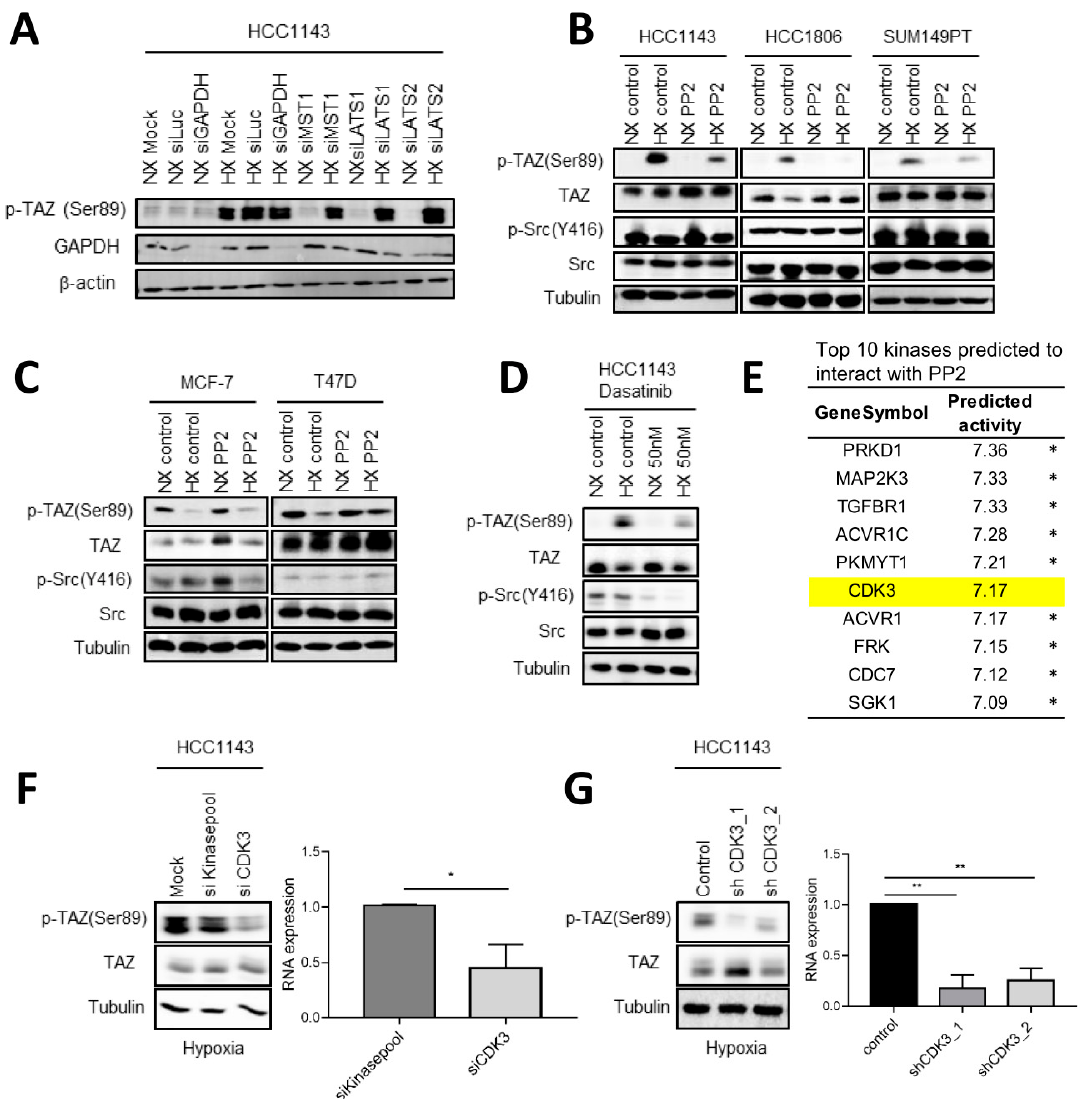
Figure 8. Src and CDK3 mediate phosphorylation of TAZ on Ser89 under hypoxia in basal A cells. ( A ) Western blot analysis of p-TAZ (Ser89) in HCC1143 cells treated with the indicated SMARTpool siRNAs targeting components of the Hippo signaling cascade or luciferase or GAPDH as controls and exposed for 5 days to normoxia (NX) or hypoxia (HX) from two biological replicates. β -actin serves as loading control. ( B , C ) Western blot analysis of the indicated (phospho-)proteins in the indicated basal A ( B ) or luminal breast cancer cell lines ( C ) exposed to normoxia or hypoxia for 3 days in absence or presence of 1µM PP2. Tubulin serves as loading control. ( D ) Western blot analysis of the indicated (phospho-)proteins in HCC1143 basal A cells exposed to normoxia or hypoxia for 3 days in absence or presence of 50nM Dasatinib. ( E ) Top 10 kinases identified as candidate PP2 substrates by ChEMBL ranked by activity. * Indicates kinases where interaction with Dasatinib scored higher interaction with PP2. ( F , G ) Western blot analysis of TAZ and p-TAZ (Ser89) in HCC1143 cells treated with control (kinase pool) or CDK3 targeting SMARTpool siRNAs ( F ) or in HCC1143 cells transduced with control non-targeting or two different CDK3 targeting lentiviral shRNA constructs ( G ). Cells were exposed for 5 days to hypoxia. Graphs show qPCR analysis of gene silencing efficacy of the CDK3 targeting siRNA SMARTpool ( F ) or the CDK3 targeting